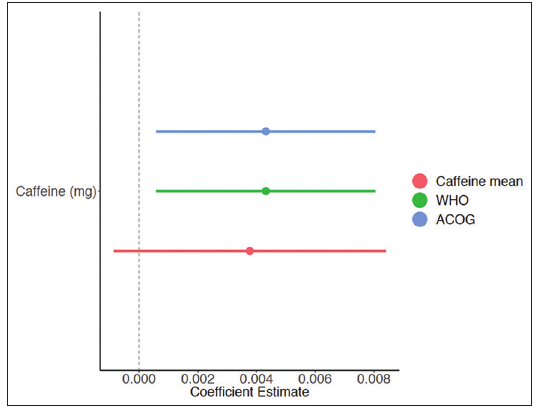
Figure 1: Regression Coefficients of Caffeine Effect on Telomere Length Stratified by Cutoff Point for Caffeine (Sample Mean, WHO Recommendation, and ACOG Recommendation)